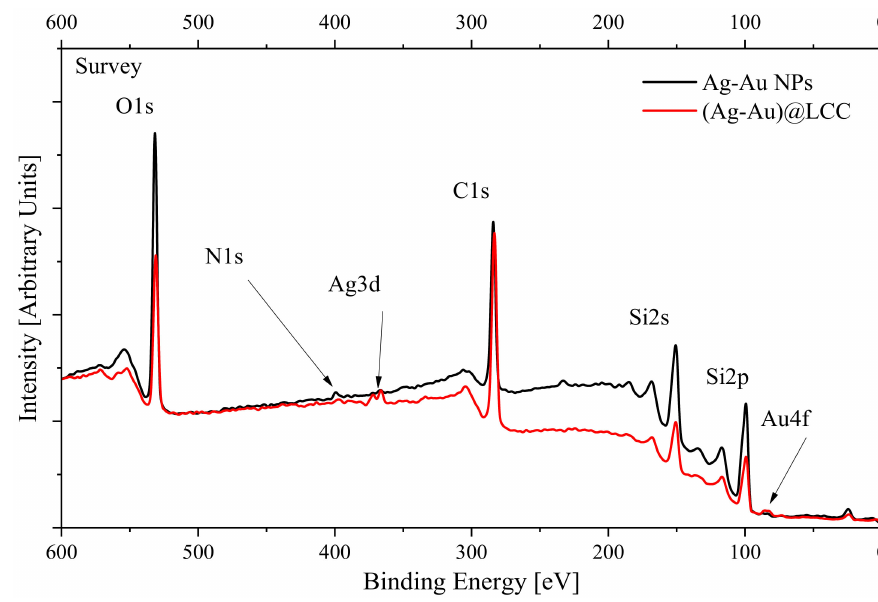
Figure 3. XPS survey spectra of Ag-Au and (Ag-Au)@LCC. Table 1. Surface composition of Ag-Au and (Ag-Au)@LCC nanoparticles (in at.